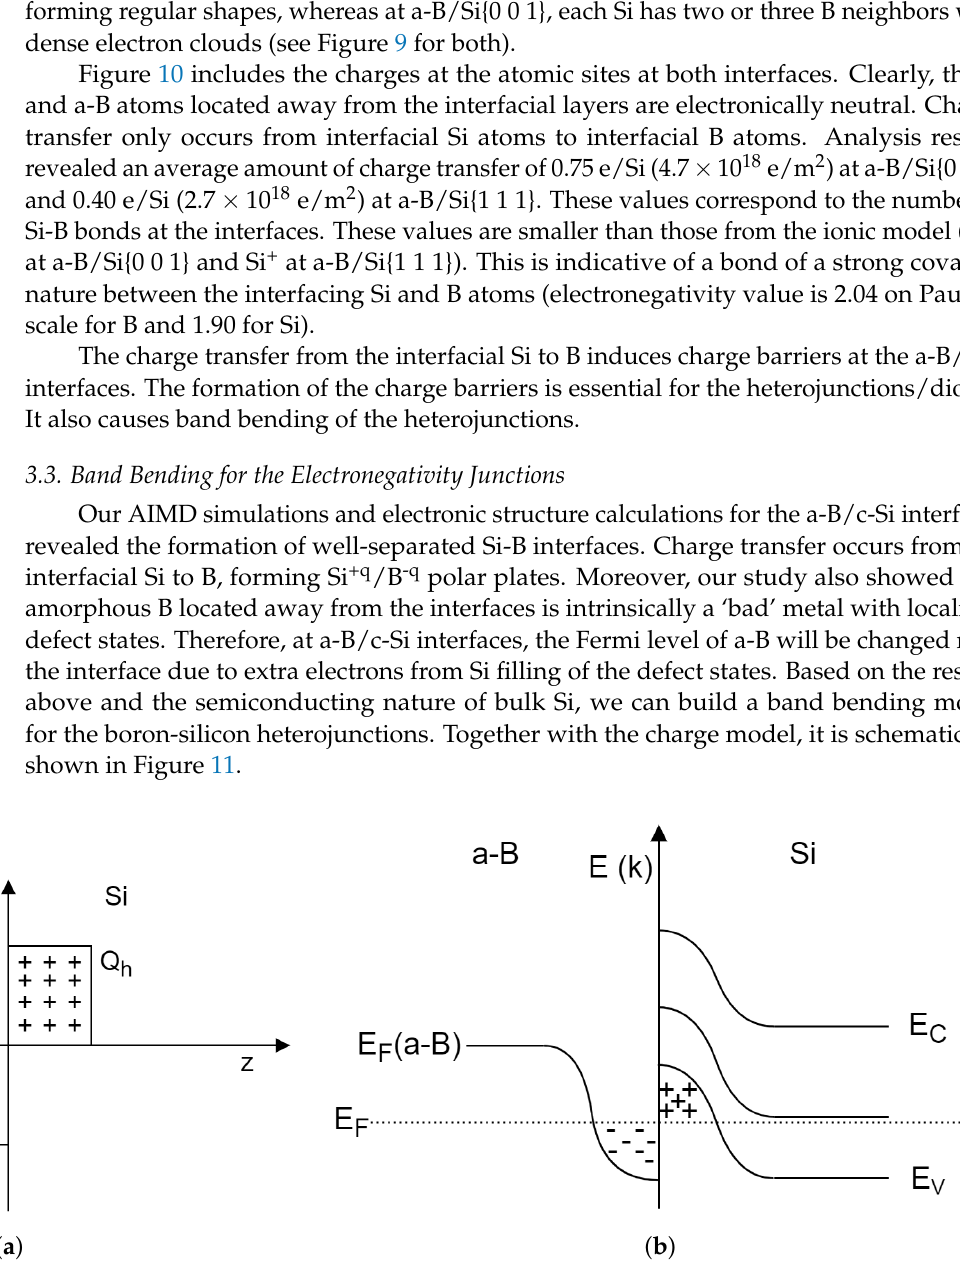
Figure 11. A schematic drawing of ( a ) charging and ( b ) band bending at the ideal Si/a-B. Charge density is 4.7 · 10 18 e/m 2 at Si{0 0 1}/a-B and 2.7 · 10 18 e/m 2 at Si{1 1 1}/a-B based on the first-principles